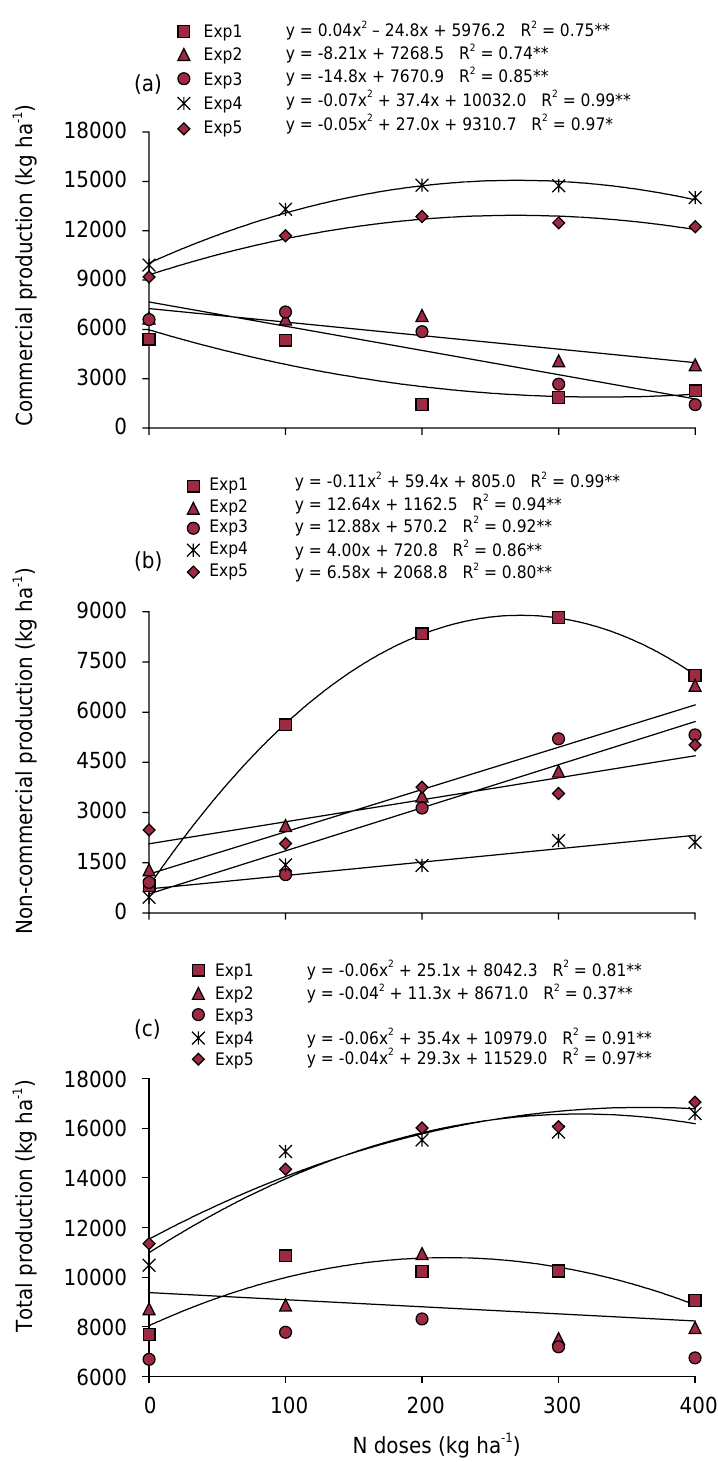
Figure 1. Commercial (a), non-commercial (b), and total production (c) of garlic virus-free due to the application of increasing N doses in five experiments. * , ** , ns : significant at 5 and 1 % of probability,